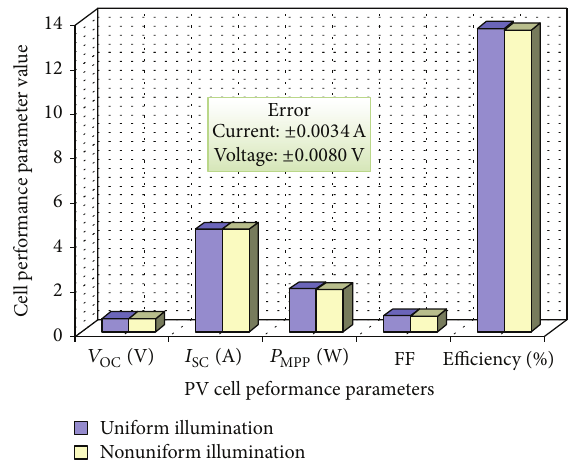
Figure 6: Comparison of various PV cell performance parameters ( 𝑉 OC , 𝐼 SC , 𝑃 MPP ,FF,and 𝜂 )foruniformandnonuniformillumination profiles. The level of nonuniform illumination was 50% of the total cell